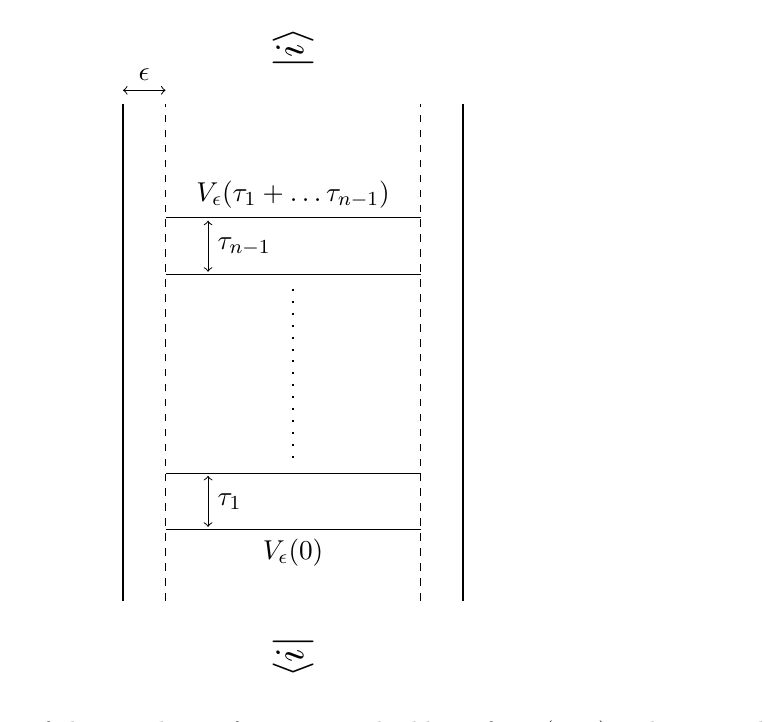
Figure 5. A depiction of the correlation function on the l.h.s. of eq. (3.15). The vertical thick lines denote the boundary of AdS . The horizontal lines denote insertions of the regulated potential 2 V (cid:15) , as defined in eq. (3.13). The subtractions of disconnected pieces, which define the connected correlator in eq. (3.15), are not